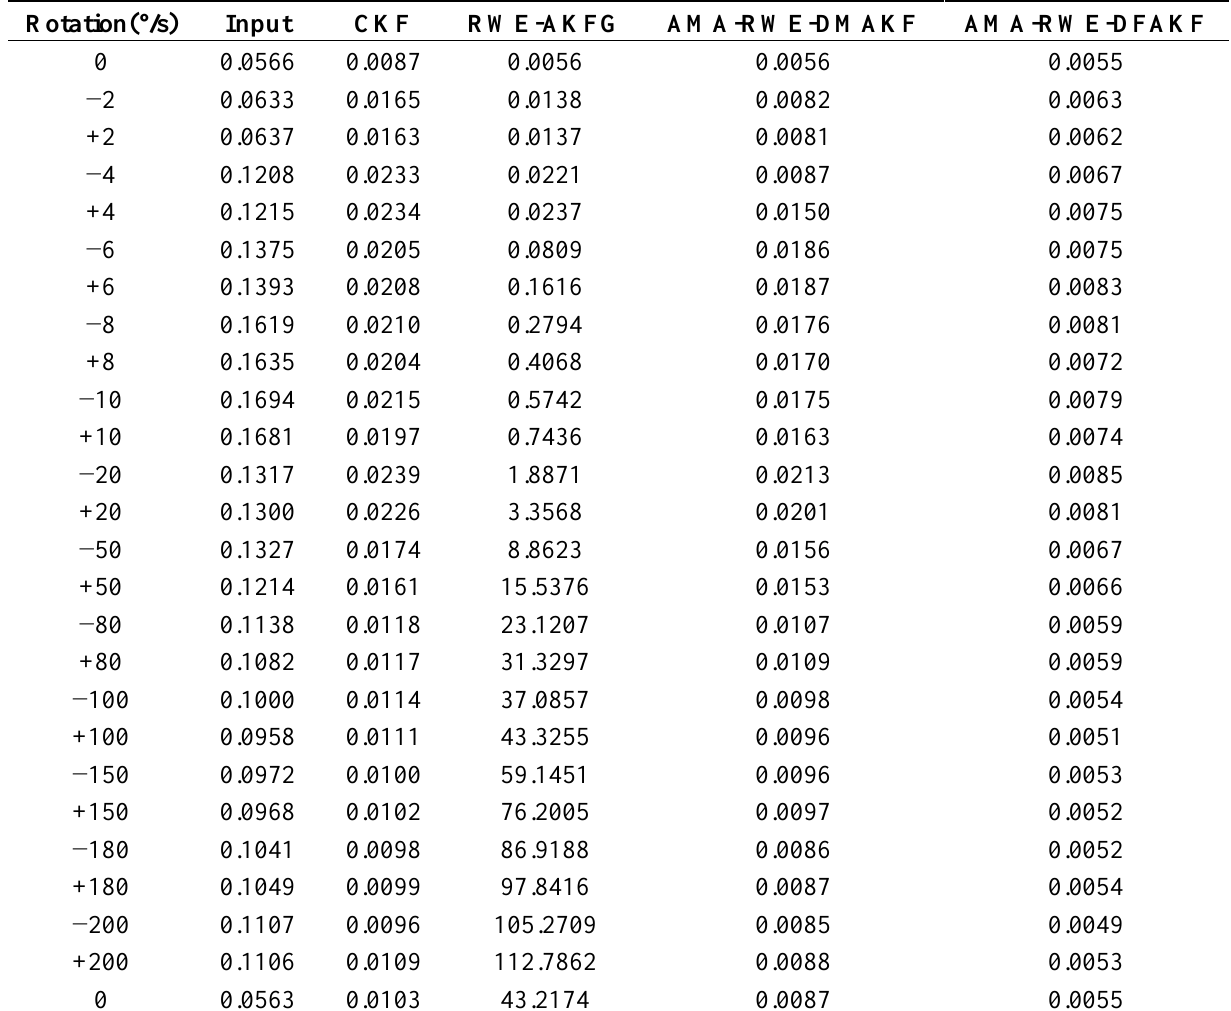
Table 3. RMSE results of ±200°/s FOG dynamic signal with sampling 200